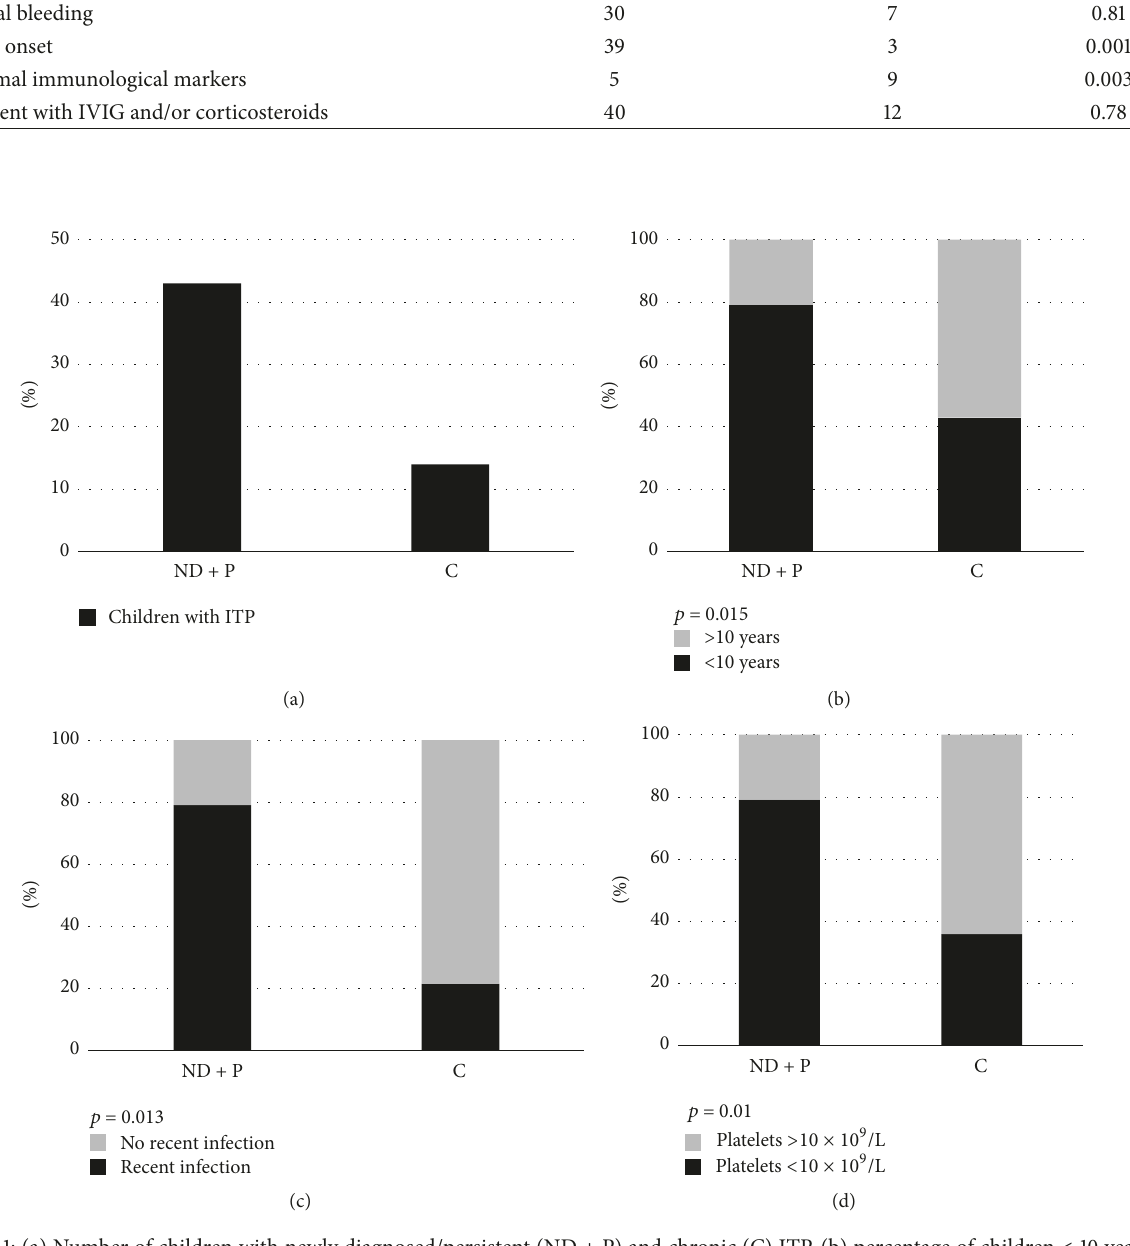
Figure 1: (a) Number of children with newly diagnosed/persistent (ND + P) and chronic (C) ITP, (b) percentage of children < 10 years or > 10 years of age, (c) percentage of children with a history of recent infection or not, and (d) percentage of children with platelets less or more than 10 × 10 9 /L, at